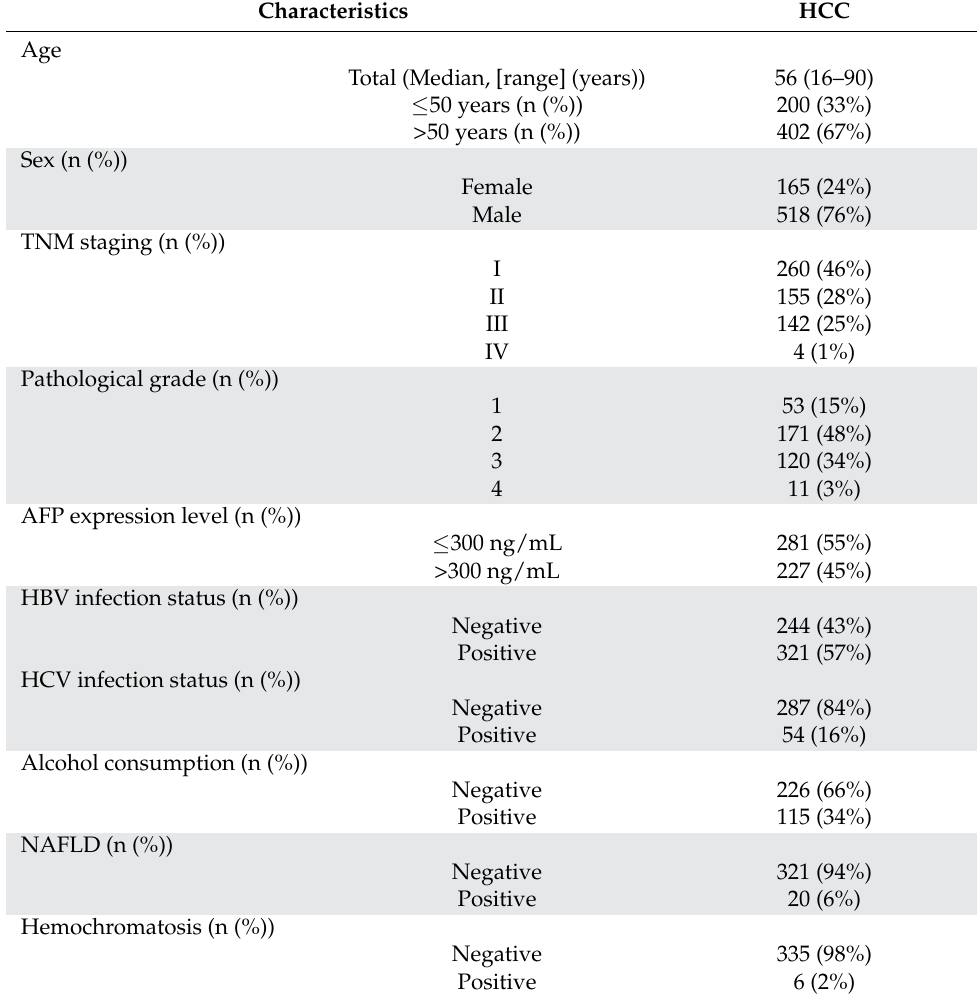
Table 1. Clinicopathological characteristics of HCC samples (N =